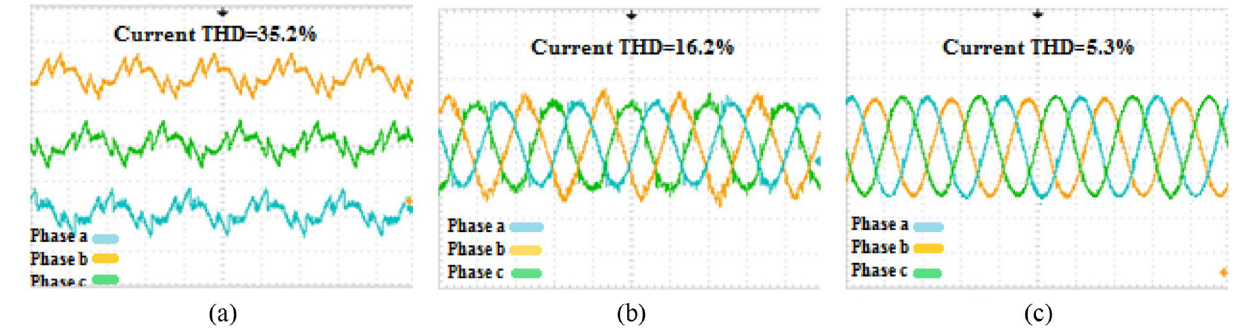
Figure 19. The experimental results of the current THD; ( a ) THDi without compensator, ( b ) THDi with UPQC, ( c ) THDi with M-UPQC.